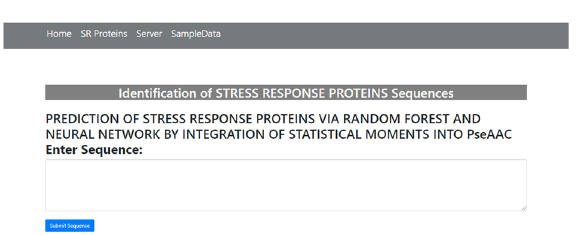
Figure 16. Prediction server page.